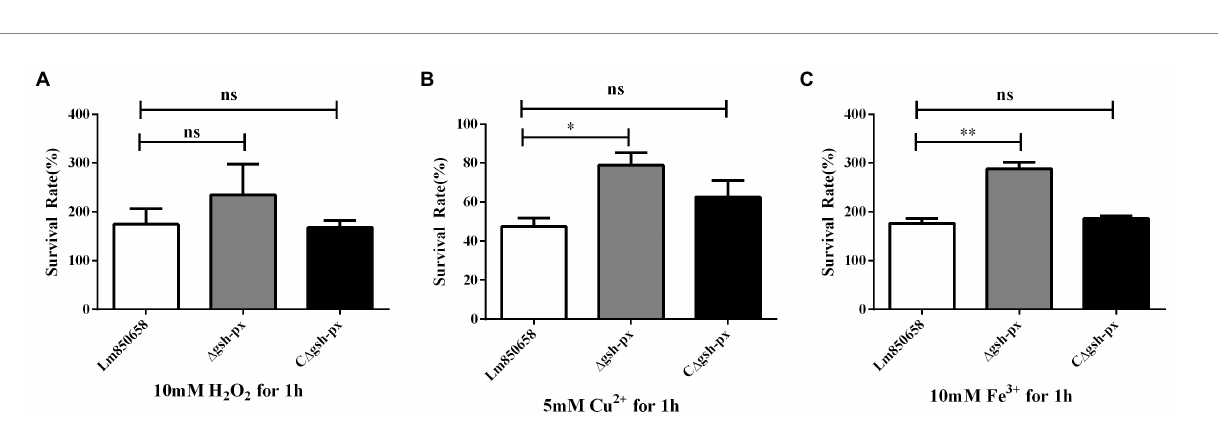
FIGURE 2 Deletion gsh-px of L. monocytogenes increased the tolerance to copper and iron, but not to hydrogen peroxide. Bacteria were treated with 10 mM